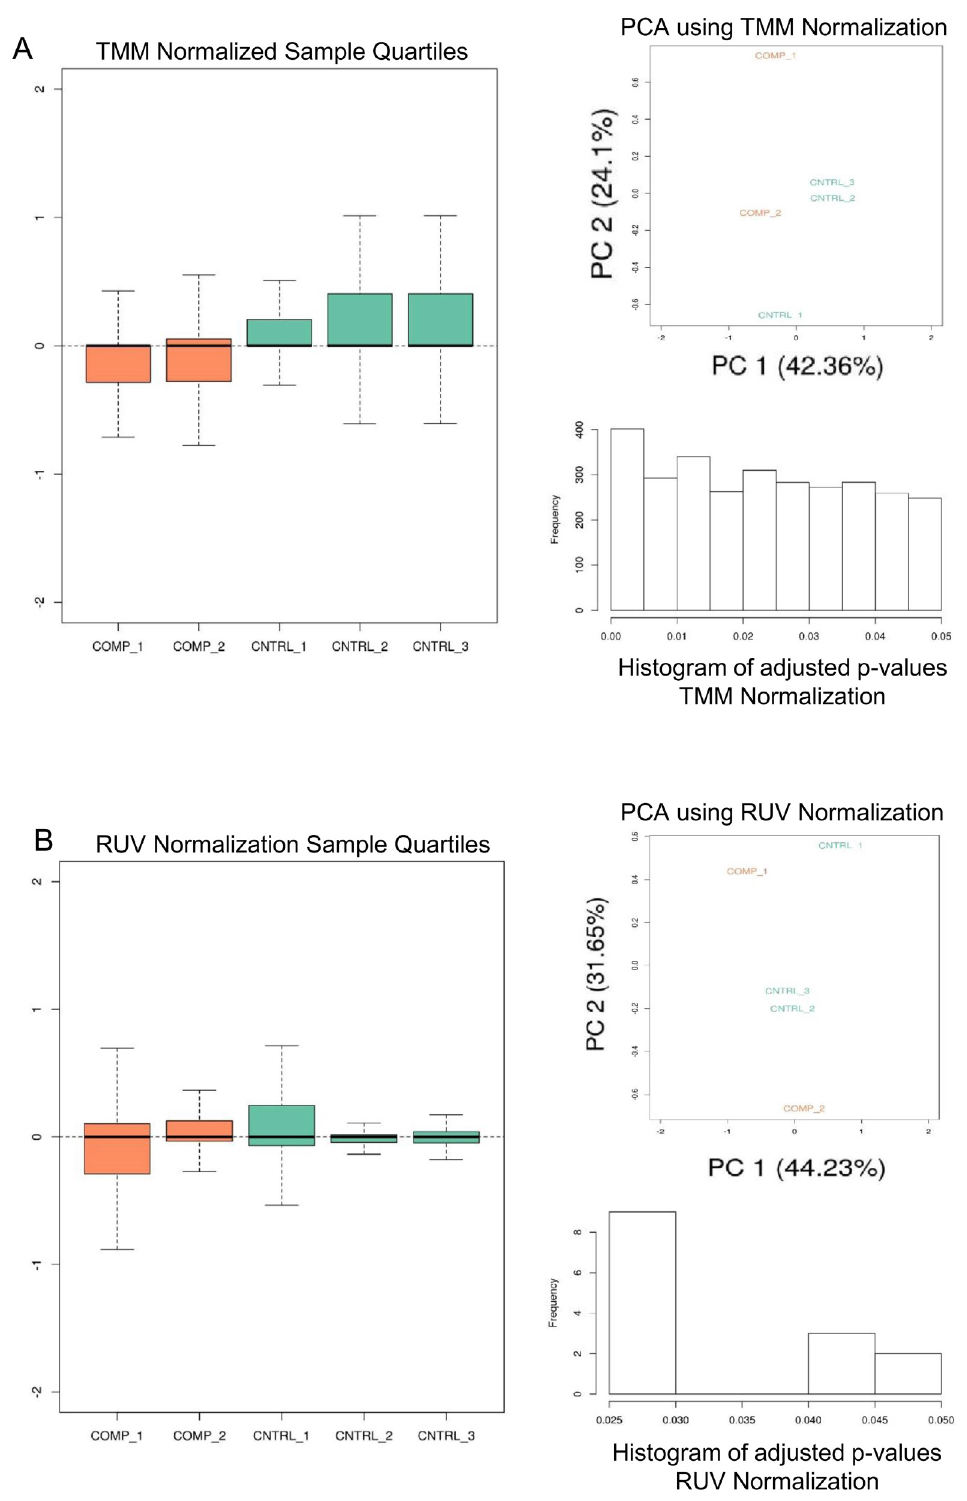
Figure 2. Arkas-Analysis Normalization Report: Normalization Analysis Using TMM and RUV. A ) TMM normalization is performed on sample data and depicts the sample quantiles on normalized sample expression, PCA plot, and histogram of the adjusted p-values calculated from the DE analysis. Orange is the comparison group and green is the control group. B ) A similar analysis is performed with RUV in-silico normalization.